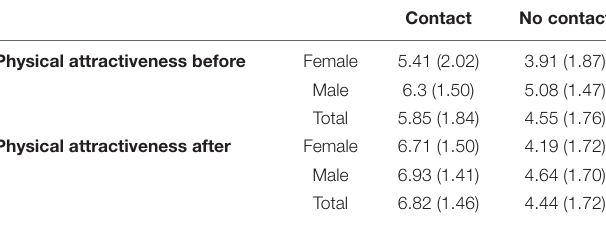
TABLE 5 | Physical attractiveness of the partner perceived by the participant before and after the speed dates in function of the interest in exchange or not contact with them for females and